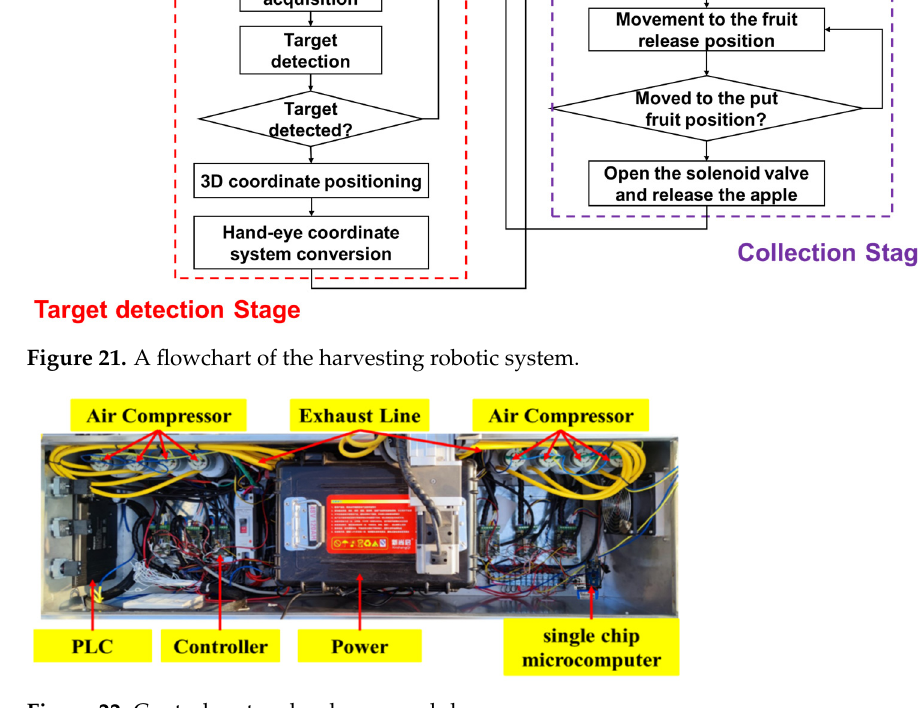
Figure 21. A flowchart of the harvesting robotic system.